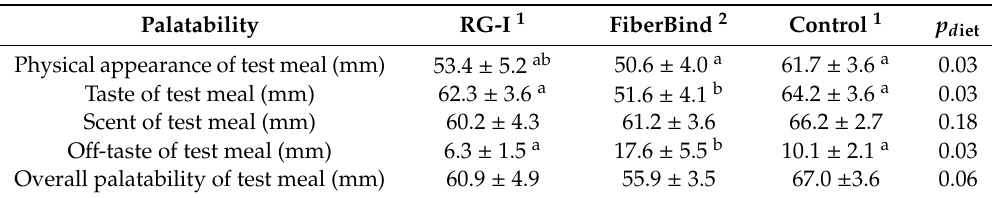
Table 4. Palatability ratings of the three test meals.